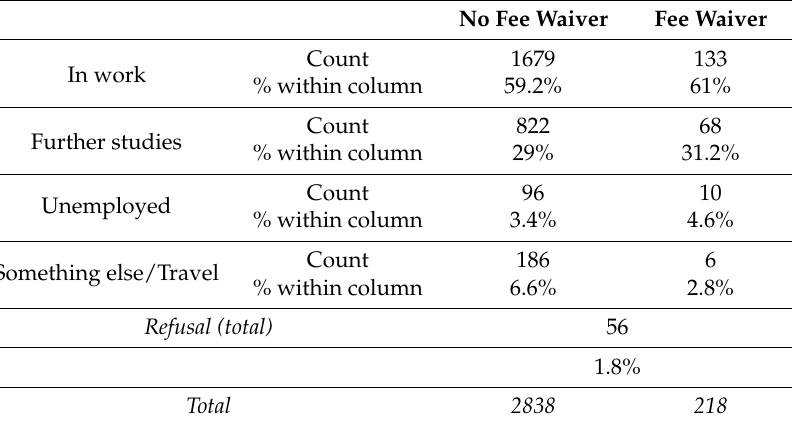
Table 1. Activity by fee waiver status.